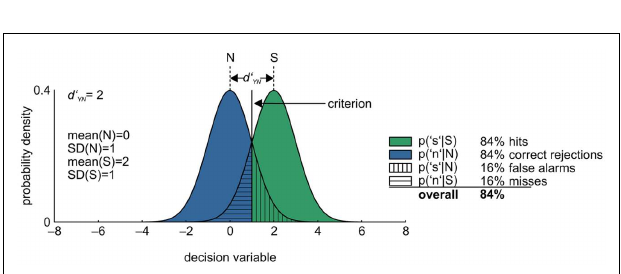
FIGURE 3 | Signal detection theoretical process model of performance in the yes/no task. See main text for details.